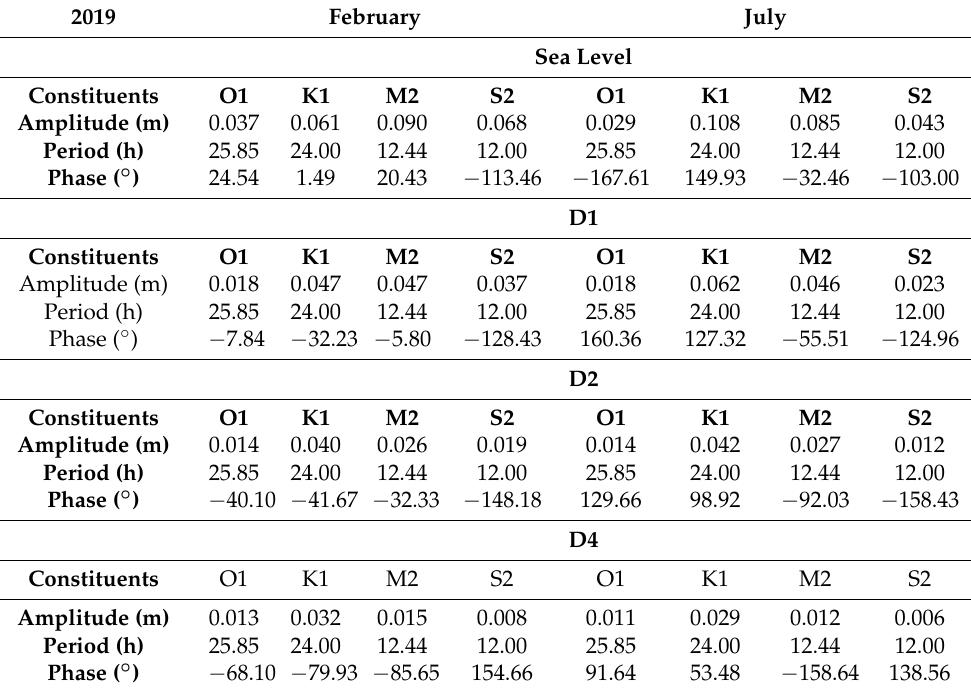
Figure 6. Analysis of observed time series: ( a ) Amplitude spectral density (ASD) for sea level and piezometric head D1, D2, and D4—February 2019; ( b ) cross-correlation functions for sea level and piezometric head D1, D2, and D4—February 2019; ( c ) Amplitude spectral density (AD) for sea level and piezometric head D1, D2, and D4—July 2019; ( d ) cross-correlation functions for sea level and piezometric head D1, D2, and D4—July 2019. Table 2. Harmonic constituent variables for sea level and piezometric head signals in D1, D2, and D4 for period of February and July